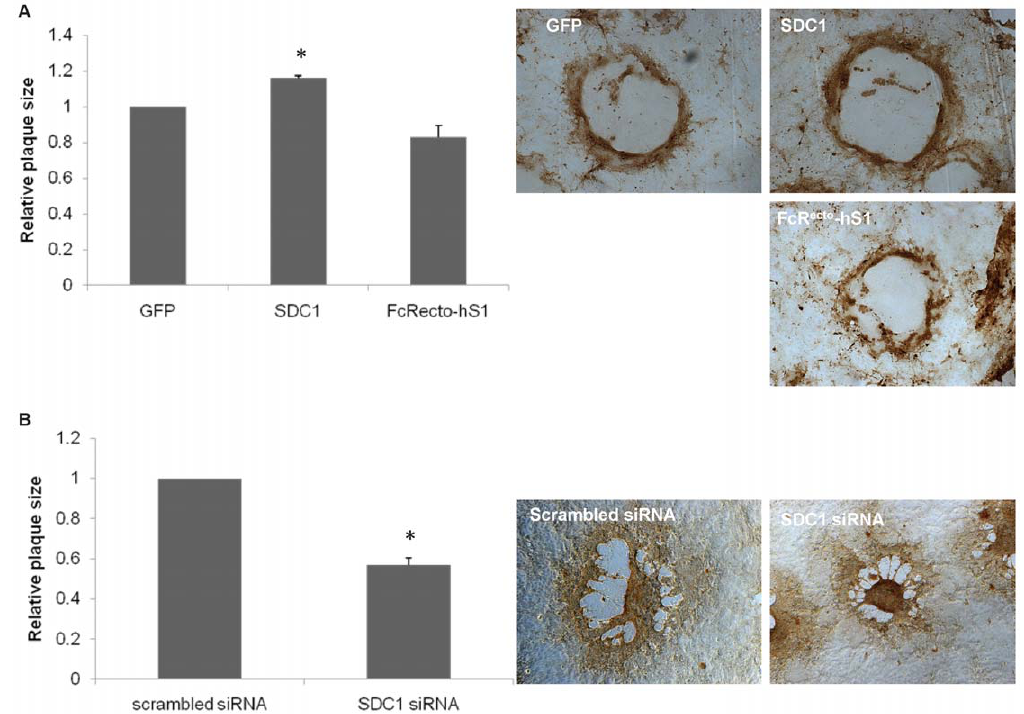
Figure 6. Effect of syndecan-1 overexpression, or downreguulation on HSV-1 plaque size. Monolayers of HCE cells were transfected with either control GFP plasmid, full-length wt syndecan-1 (SDC1), or the construct FcR ecto hS1. 24 h post-transfection, cells were infected with HSV-1 (KOS) at an MOI of 0.1 and overlaid with 0.5% methylcellulose medium. (B) 50% confluent HCE cells were transfected with either control scrambled siRNA or syndecan-1 sprecific siRNA. 72 h post-transfection, cells were infected with HSV-1 (KOS) at an MOI of 0.1 and overlaid with 0.5% methylcellulose medium. (A, B). 72 h post-infection cells were fixed and stained using rabbit anti-HSV-1, horseradish peroxidase-conjugated secondary antibody, and 3,3 9 -diaminobenzidine tetrahydrochloride (DAB) substrate. Plaques were measured with a micrometer at the 10 6 objective (Zeiss Axiovert 200), and the area was calculated by measuring the outline of each plaque using Axioversion software (version 4). Results are expressed as relative plaque size (means 6 1 SD) of two independent experiments conducted in duplicate. Representative plaques from each condition are shown. SDC1 ,